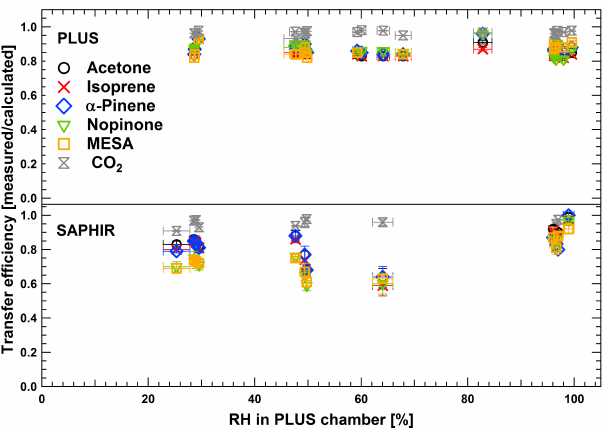
Figure 5. Illustration of monoterpene transfer from PLUS to SAPHIR when continuously coupling the chambers with a flow of 30m 3 h − 1 . Yellow shaded areas indicate time periods and intensity of light in the plant chamber; green shaded area indicates coupling of PLUS to